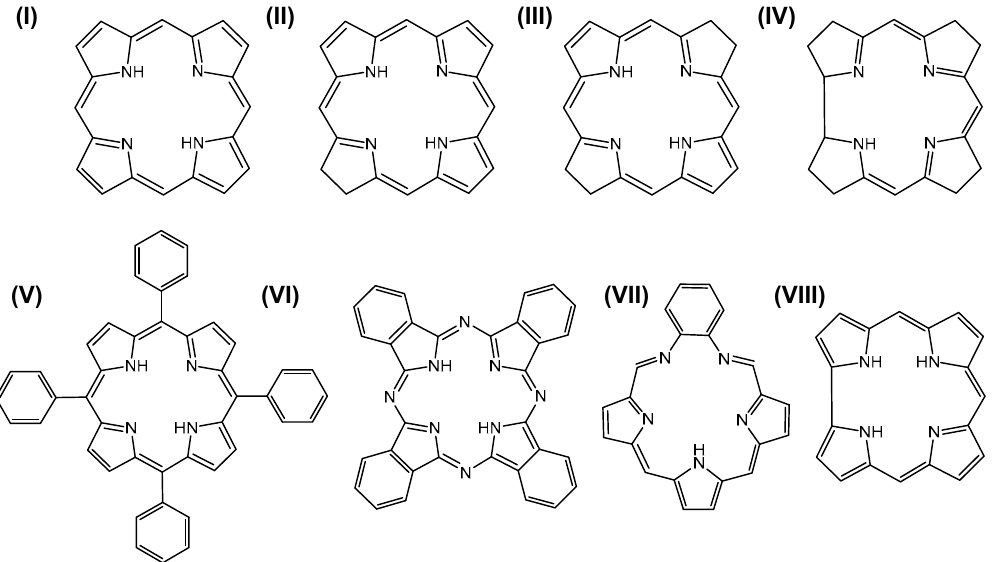
Figure 1. Structures of porphyrins ( I ), chlorins ( II ), bacteriochlorins ( III ), corrins ( IV ), tetraphenylporphyrins ( V ), phthalocyanines ( VI ), texaphyrins ( VII ), and corroles ( VIII ).